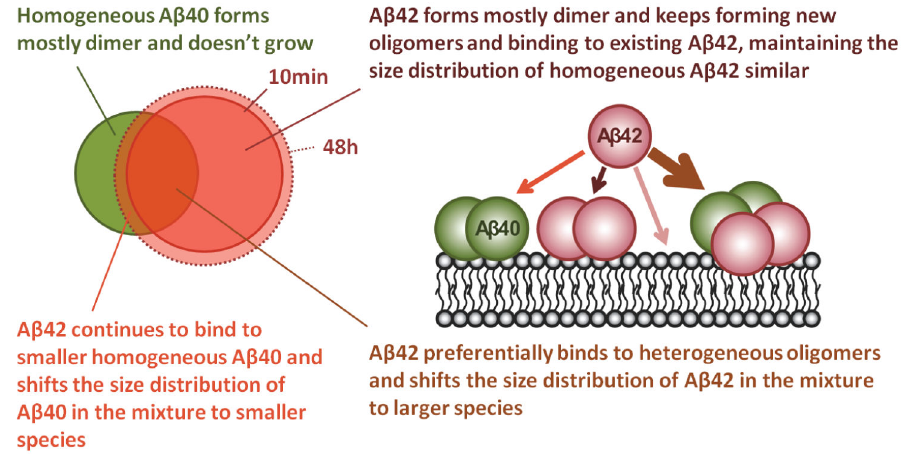
Figure 8. Summary of synergistic interactions between Aβ40 and Aβ42 on the neurons. For Aβ40, the total number of membrane bound oligomers (including both homogeneous and heterogeneous species) does not change, suggesting either no solution Aβ40 binds to the membrane or the association and dissociation of solution Aβ40 to the membrane reach the equilibrium. Size of homogeneous Aβ40 remains mostly dimeric. For Aβ42, the total number of membrane bound oligomers increases. Solution Aβ42 preferentially binds heterogeneous species, increasing the Aβ42/Aβ40 ratio in each mixture. Solution Aβ42 also binds to homogeneous Aβ40, increasing the number of heterogeneous species and shifting the fraction of Aβ40 in the heterogeneous oligomer to a slightly smaller species. However, the solution Aβ42 forms new oligomers and also binds to homogeneous Aβ42, therefore maintaining the size of homogeneous Aβ42